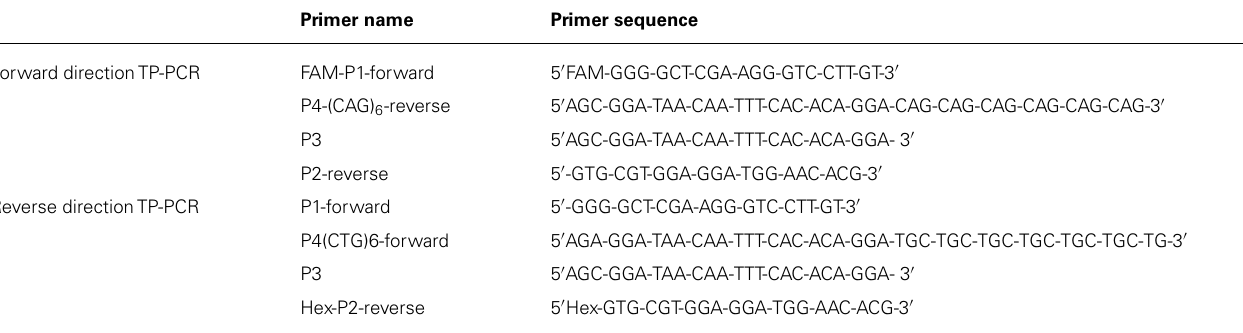
Table 1 |Triplet-Primed PCR primer